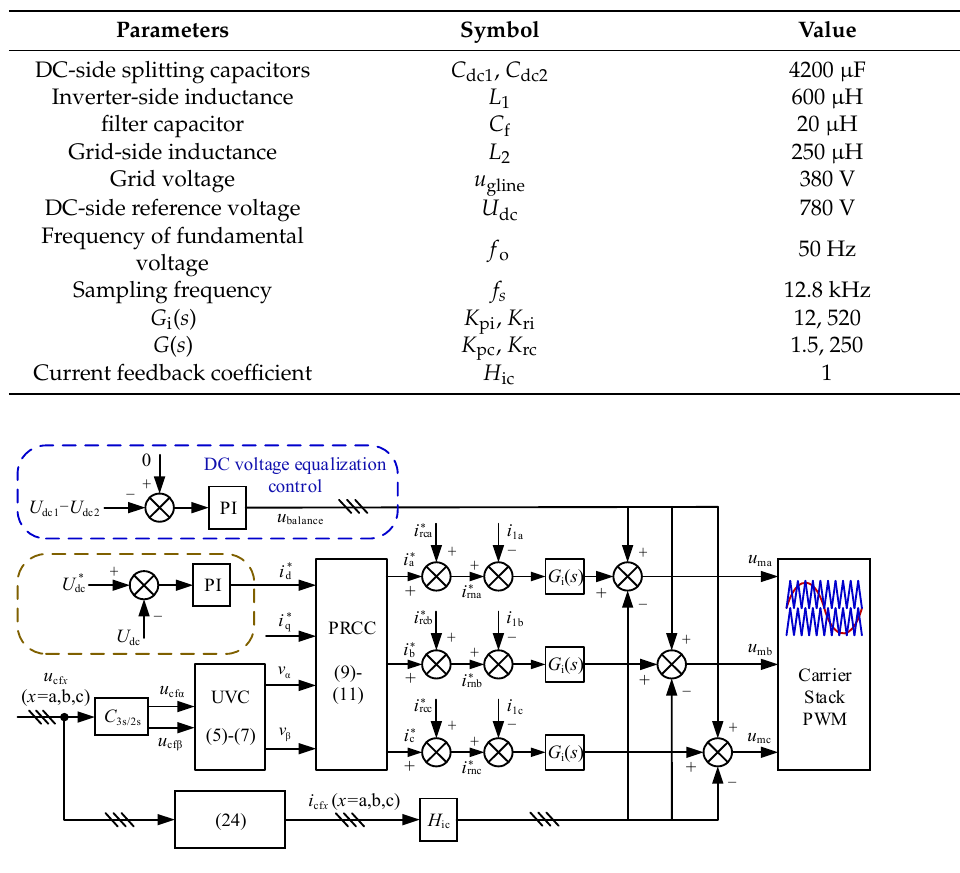
Figure 8. Control block diagram of the three-phase LCL-type grid-connected inverter system. Table 1. Parameters used for simulation.